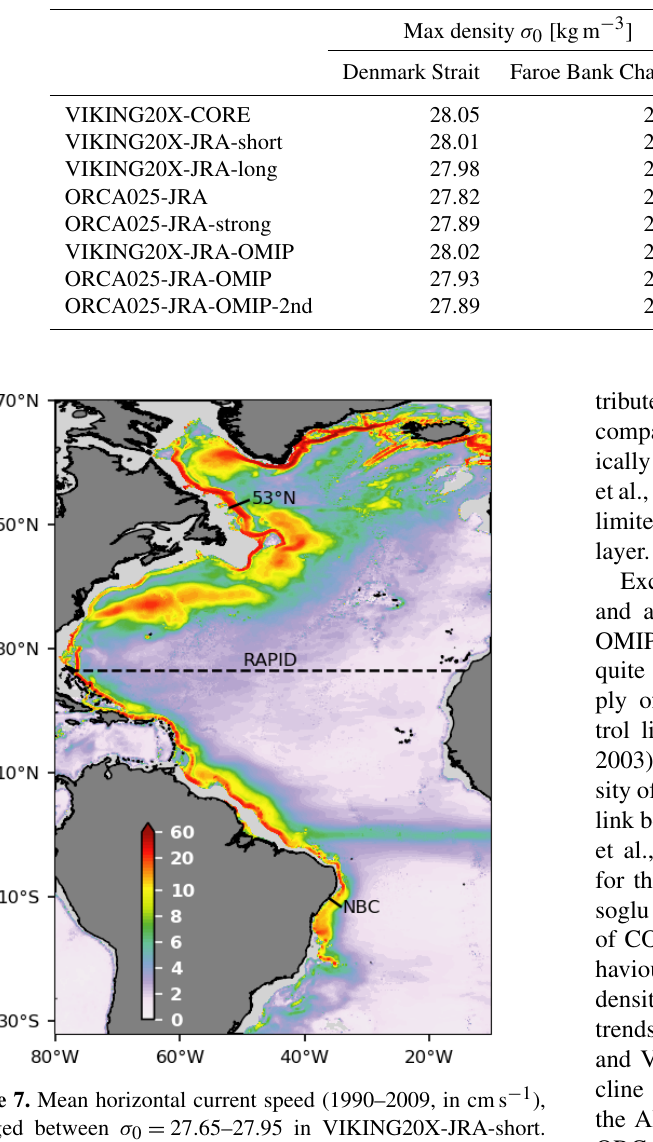
Table 3. Maximum density and overflow transports provided as mean and monthly standard deviation for the period 1990–2009 at Denmark Strait sill and Faroe Bank Channel. Overflow transports are based on southward transport of waters with density larger than 27.70kgm − 3 below 270m.